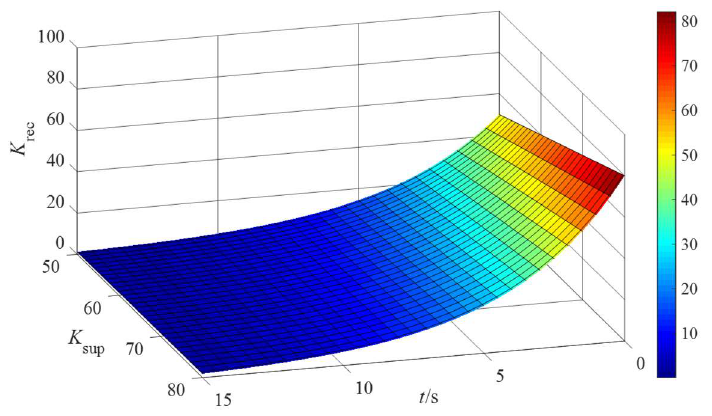
Figure 11. Diagram of the control coefficients for the proposed scheme during the RSR period.